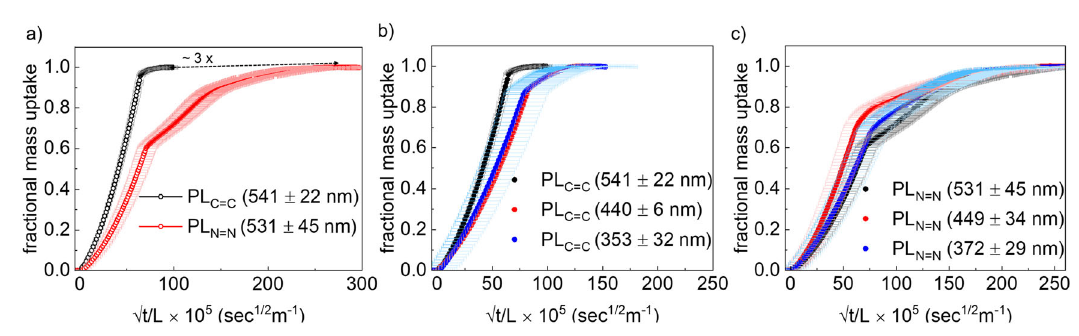
b , c fractional methanol vapor uptake rate pro fi les withdifferent fi lmthickness for PL C=C and PL N=N , respectively. Error bars calculated using thickness of the fi